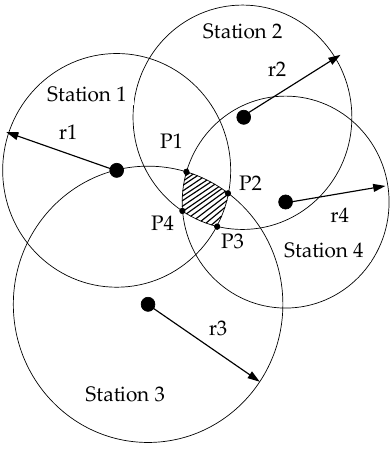
Figure 7. Four intersecting circles with evaluated errors.